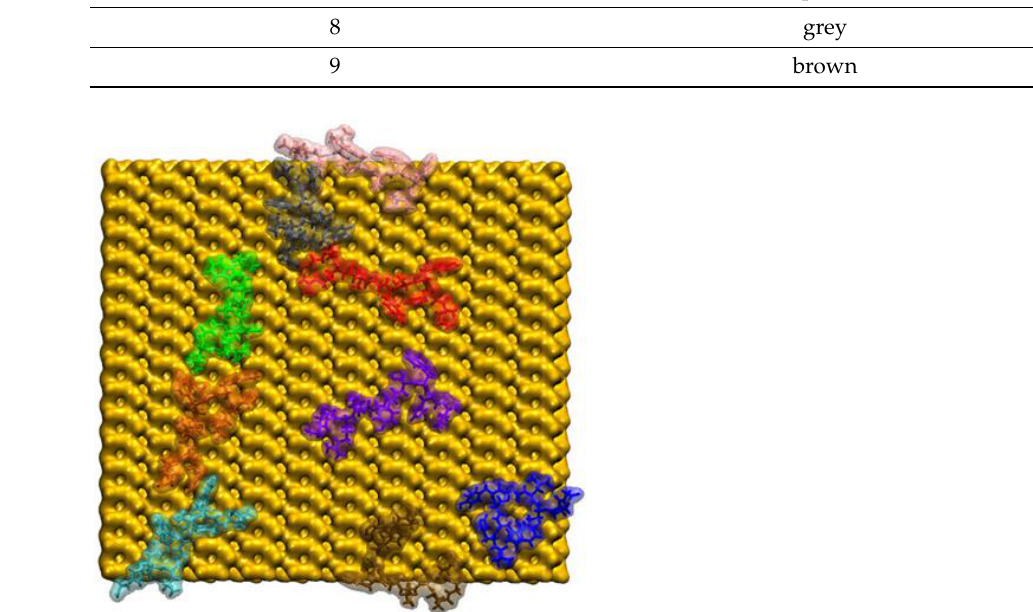
Table 1. Peptide colour scheme used in Figures 2-6.